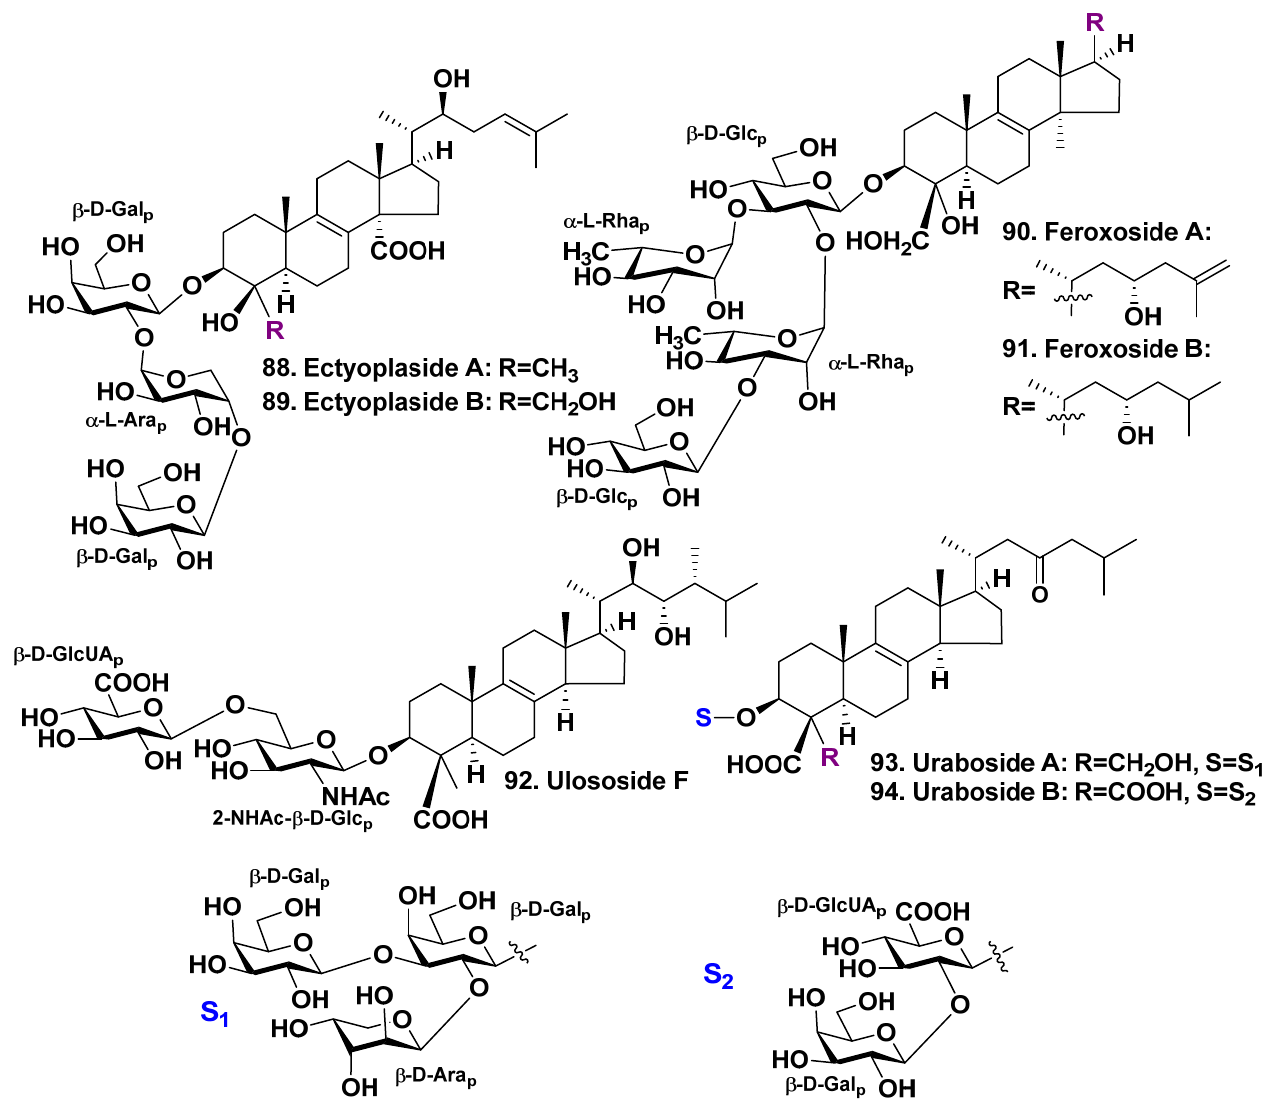
Figure 11. Glycosides 88 – 94 from Ectyoplasia ferox